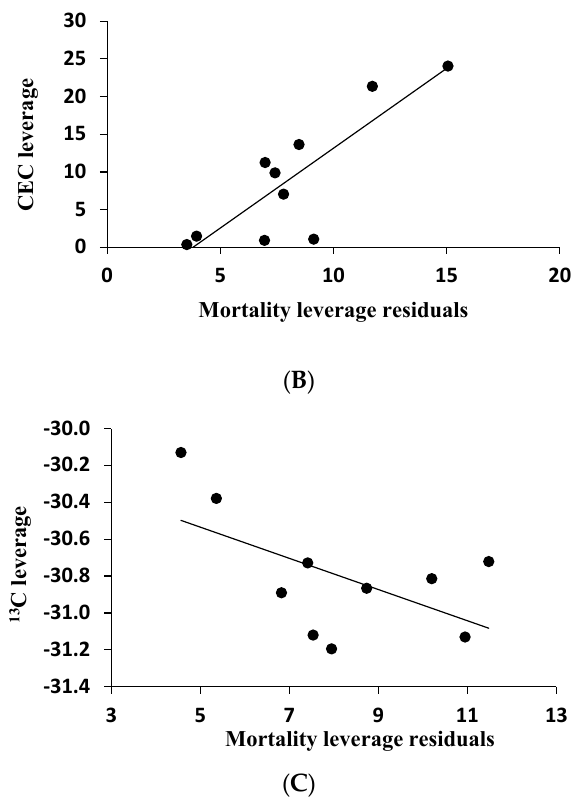
Figure 3. Multiple linear regression of western white pine mortality employed three biotic and abiotic variables explaining 88% of the variation (model R 2 = 0.88, F 3,6 = 15.19, p = 0.0029). Mountain pine beetle contributed a significant amount of predictive power to the regression model ( A ), followed by CEC ( B ), and water-use efficiency, δ 13 C ( C ).